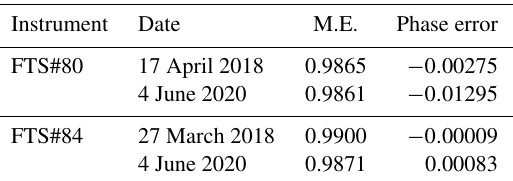
Table 1. ILS in terms of modulation efficiency (M.E.) and phase error calculated before and after the campaign for instruments FTS#80 and